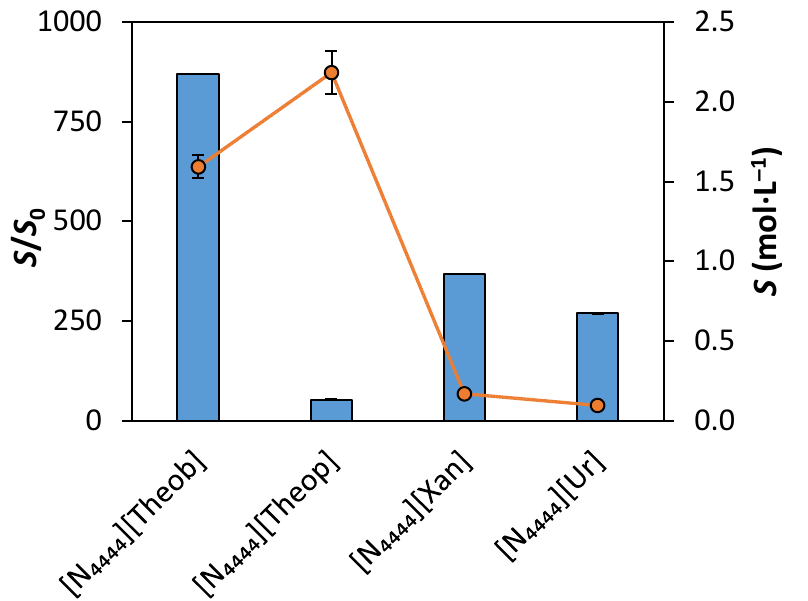
Figure 1. Aqueous solubility enhancement ( S / S 0 ) of each purine-based salt, relative to the respective free purine (blue bars) and molar solubility ( S ) of each salt in pure water (orange dots and line). S 0 values were obtained from PubChem [53].